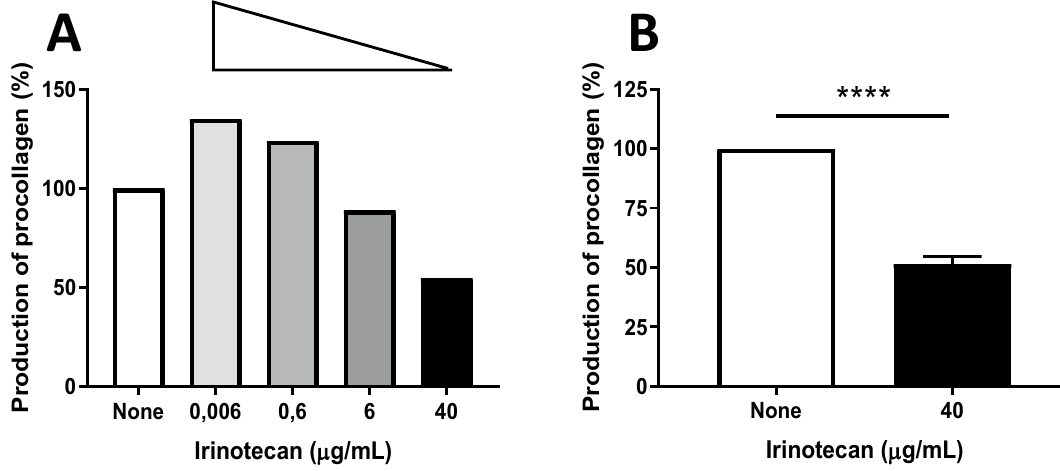
Figure 1. Analysis of irinotecan effect on procollagen I release of dermal SSc fibroblasts. The level of procollagen I release was evaluated after 48 h in dermal fibroblasts from SSc patients incubated with irinotecan. A comparison of procollagen I release level was done between non-treated condition and treated conditions. (A) Data from a representative experiment showing a dose-dependent effect on the procollagen I production of SSc fibroblasts after incubation with 4 different doses of irinotecan (i.e. 0.006 µg/ml, 0.6 µg/ml, 6 µg/ml, 40 µg/ml). (B) Cumulative data from 3 independent experiments showing a decrease of procollagen I production in SSc fibroblasts incubated with irinotecan (40 µg/ml). **** p < 0.0001 using paired